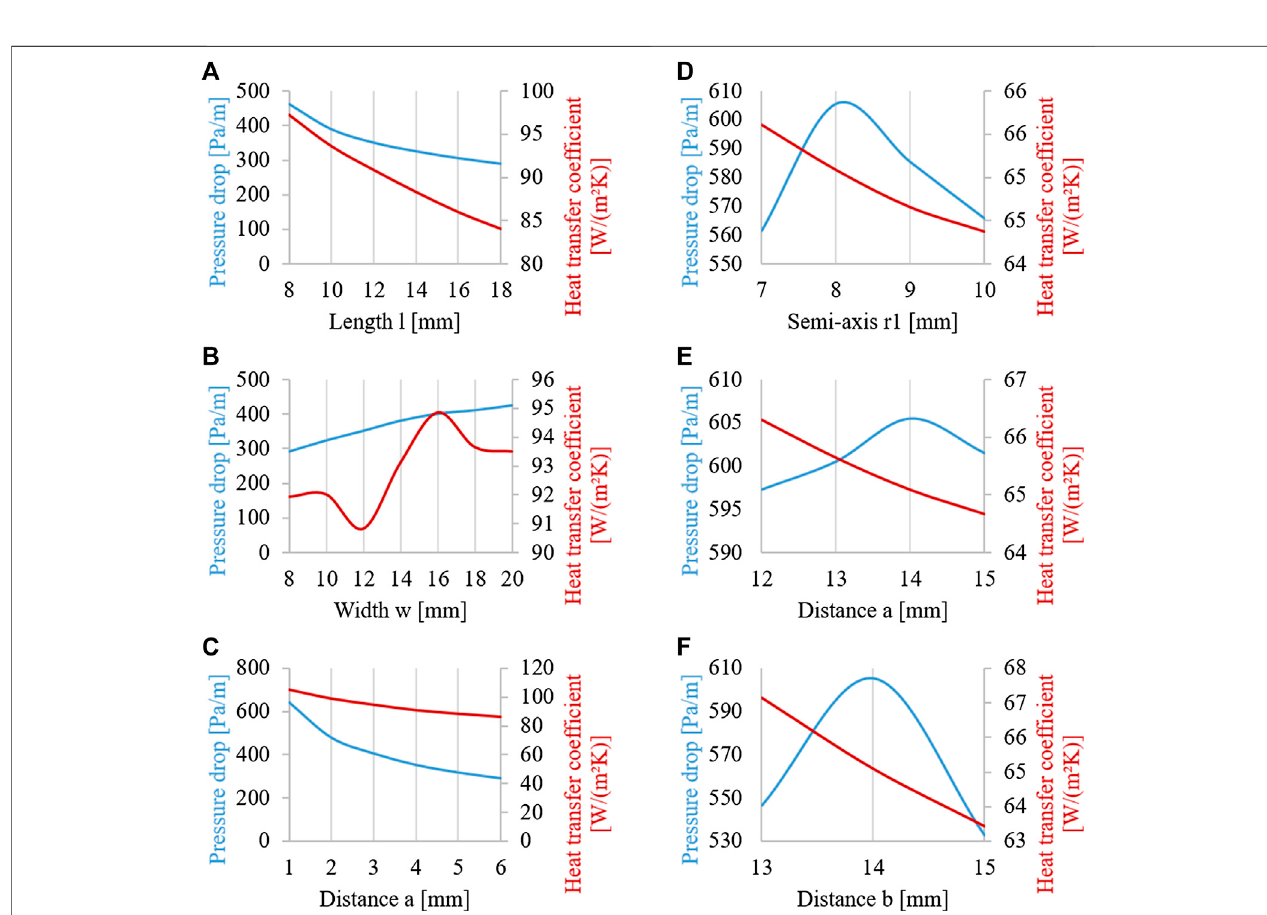
FIGURE11| Somepressuredropandheattransfercoef fi cientresultsoftheparametricstudyforapyramidalfrustum (left) andanellipsoid (right) basedgeometry: variation of frustum base length l (A) , base width w (B) and distance a between frustums (C) as well as variation of ellipsoid axis r1 (D) , distance a (E) and distance b (F) .